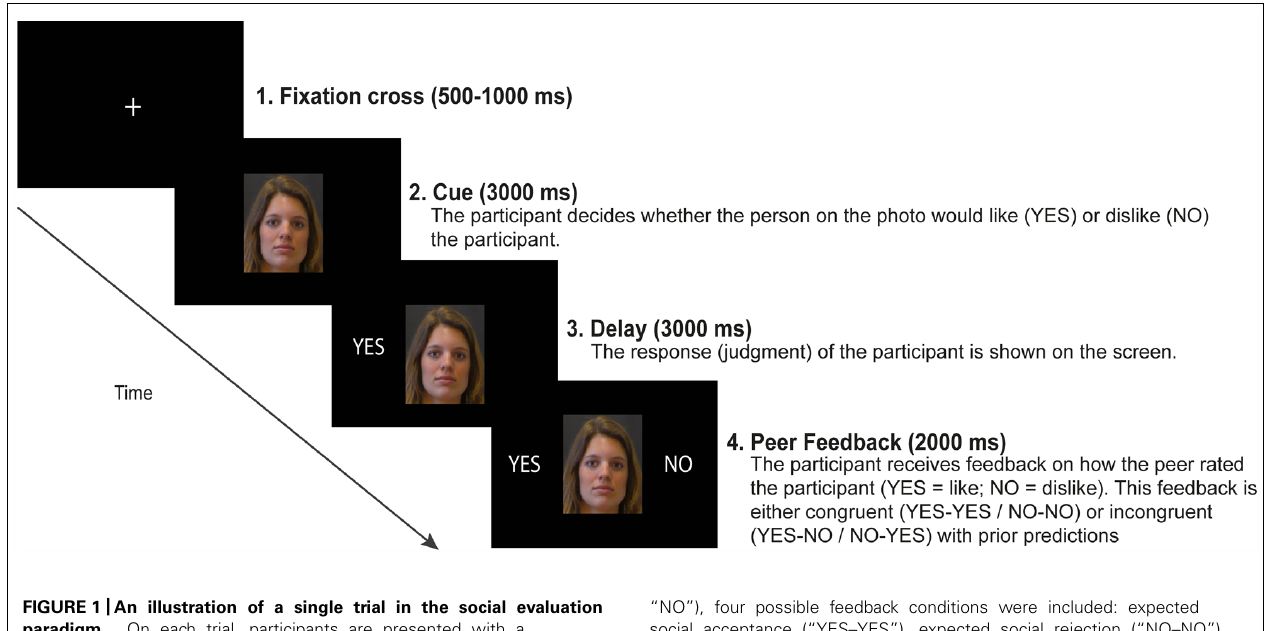
FIGURE 1 |An illustration of a single trial in the social evaluation paradigm. On each trial, participants are presented with a photograph of a peer. The participant is asked to judge whether the peer would either like (accept) or dislike (reject) the participant. Based on judgment type (“YES” or “NO”) and feedback type (“YES”